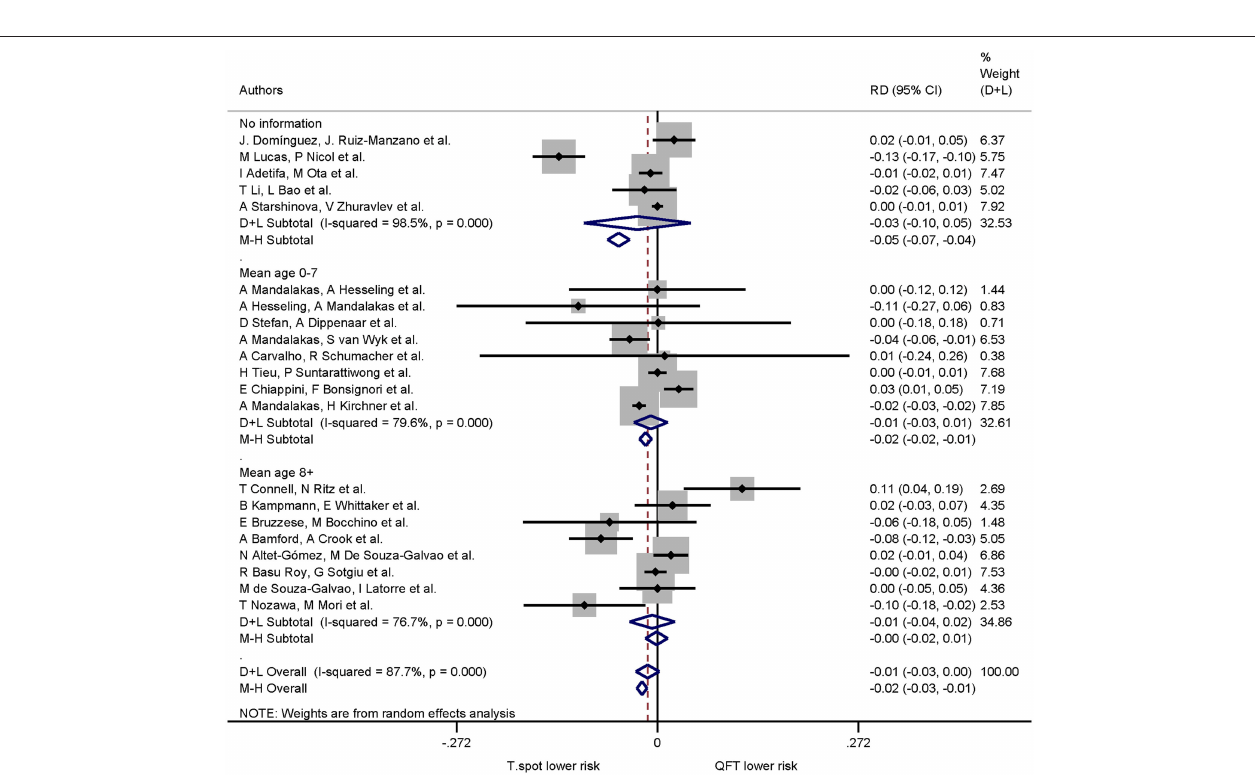
FIGURE 4 | Risk differences (RD) with 95% CI in studies that included a head-to-head comparison of QuantiFERON-TB and T-SPOT.TB assays stratified by age. Studies sorted according to year of publication.